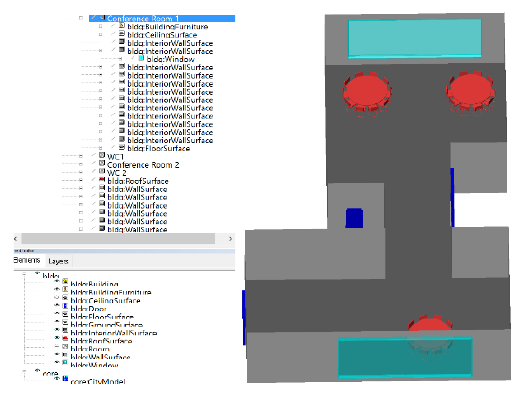
Figure 7: Semantic examination of the CityGML LoD 4 model in FZK Viewer